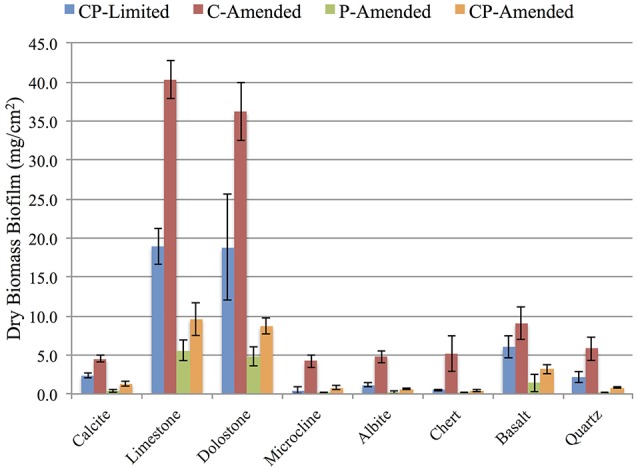
Dry weight (mg/cm2) of biomass accumulation on surfaces for each reactor treatment. Error bars denote standard deviation, n = 3. See Supplementary Table 1 for values.